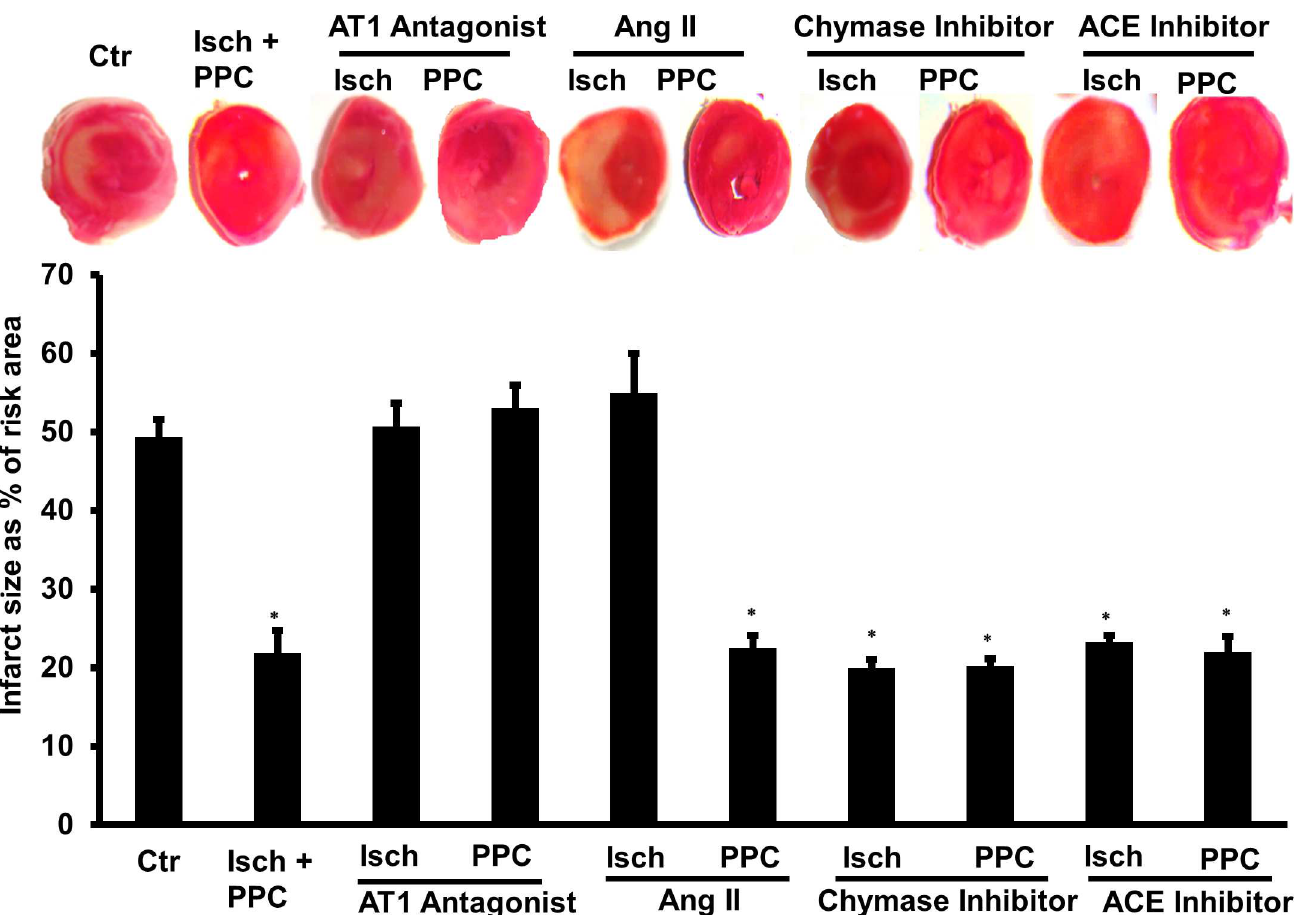
Fig 3. Infarct size determination by TTC staining. Isolated rat hearts at the end of reperfusion (n = 4) were sectioned and stained with TTC (upper panel). Infarct size was quantifiedand expressedas a percentageof total LV area (lower panel). Ctr, control; Isch, ischemia; PPC, pacing postconditioning. * P < 0.001 compared to respective